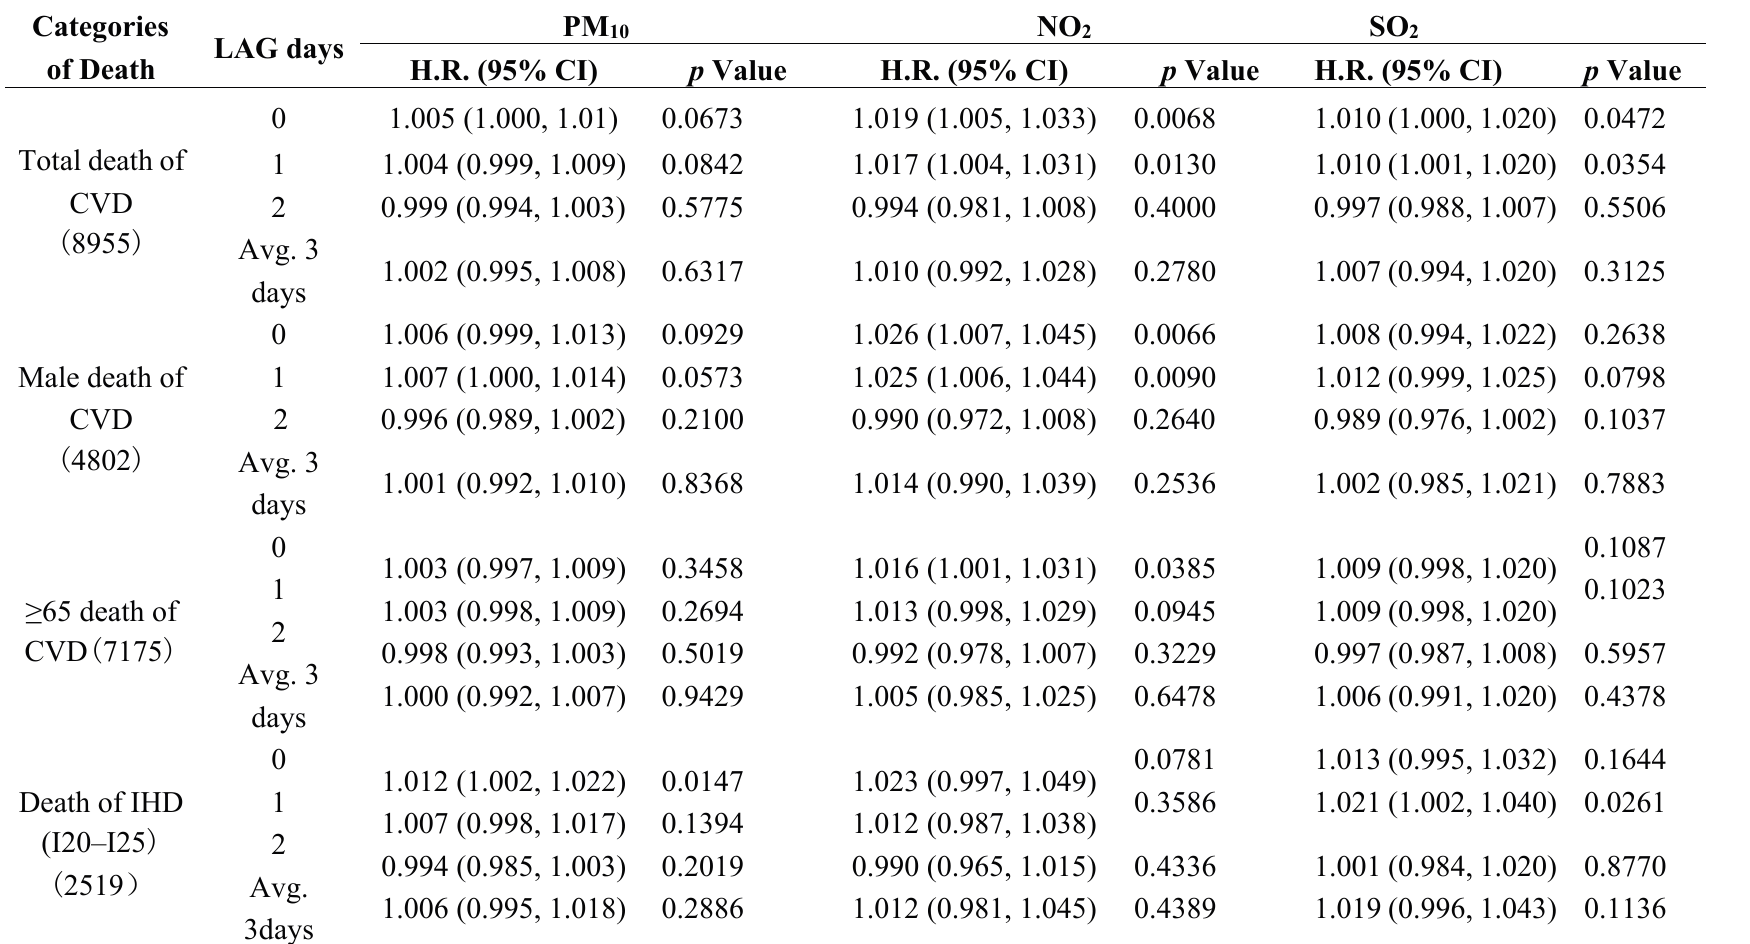
Table 4. Associations between air pollutants and CVD mortality among urban residents in